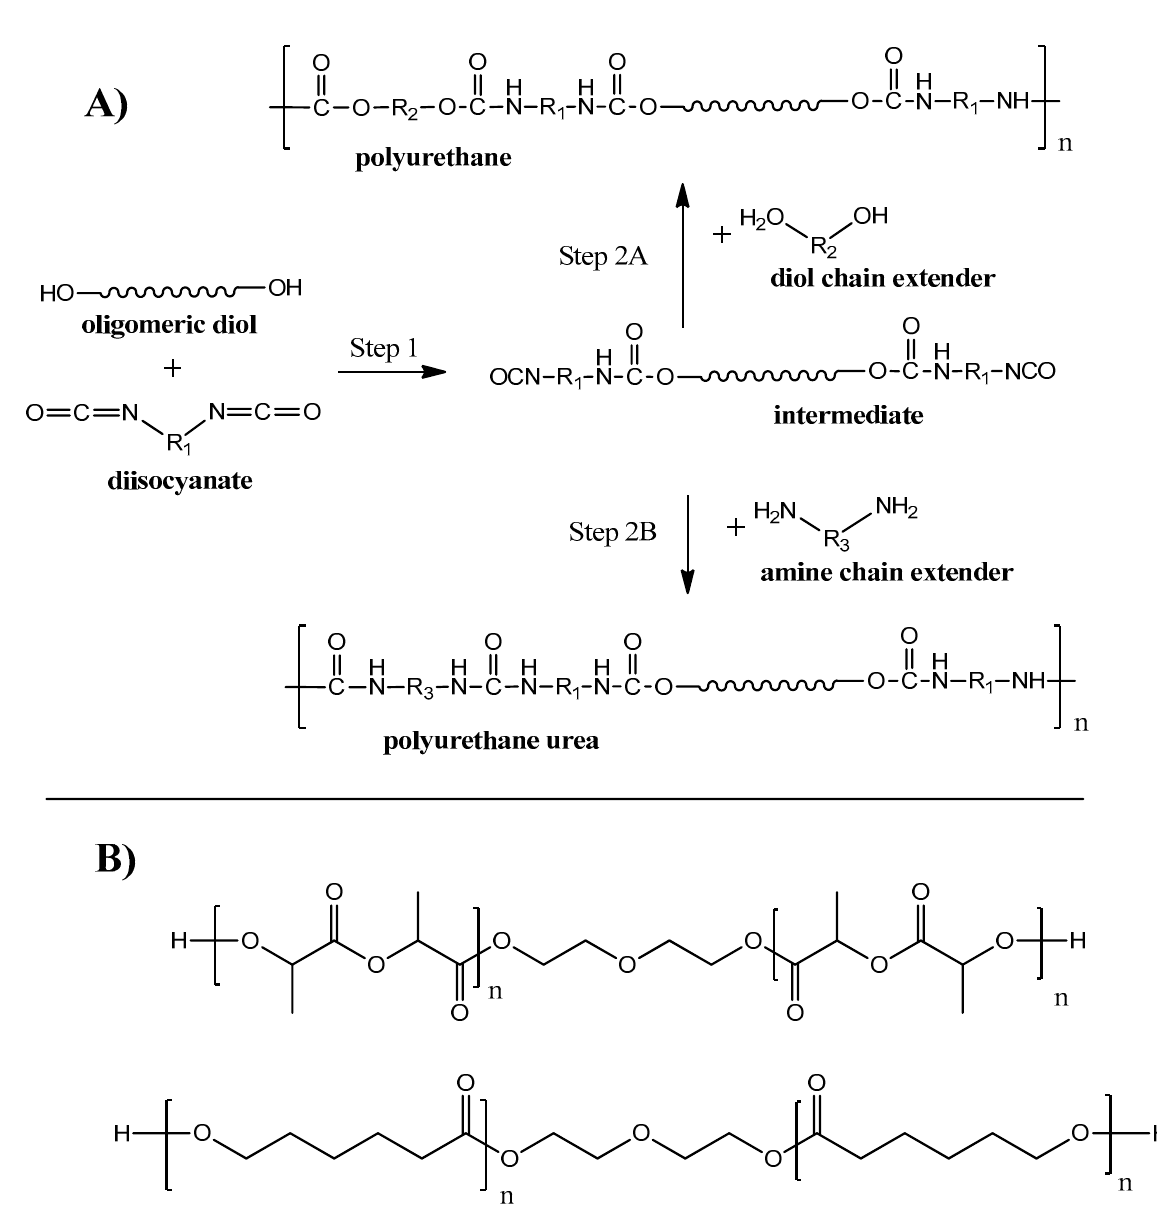
Figure 8. Synthesis routes of biodegradable PU and PU urea. Table 1. Green chemistry biodegradable membranes chemistry and